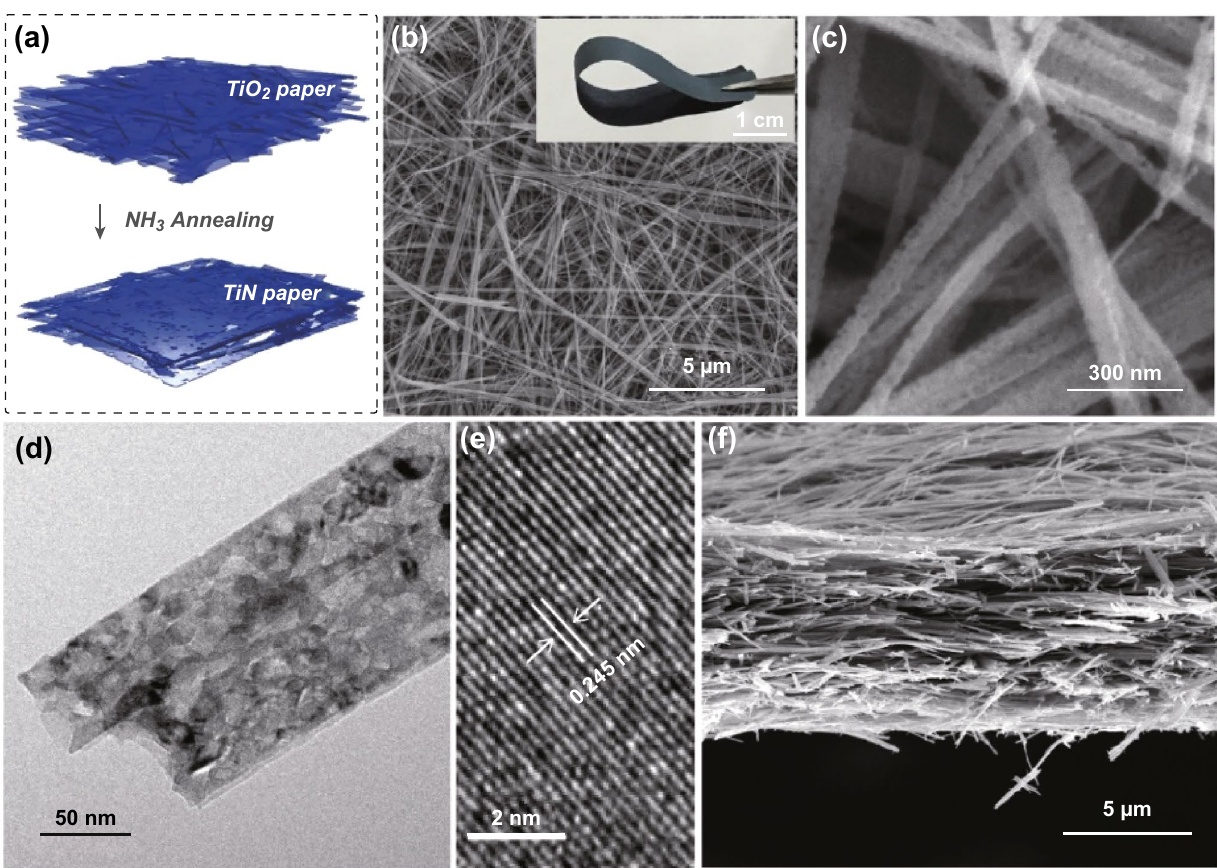
Fig. 1 a Schematic illustration of the fabrication process of TiN paper from TiO 2 paper. b , c SEM images of TiN nanobelts. Inset in b shows the digital image of a piece of flexible TiN paper. d , e TEM and high-resolution TEM images of porous TiN nanobelts. f Cross-sectional SEM image of TiN